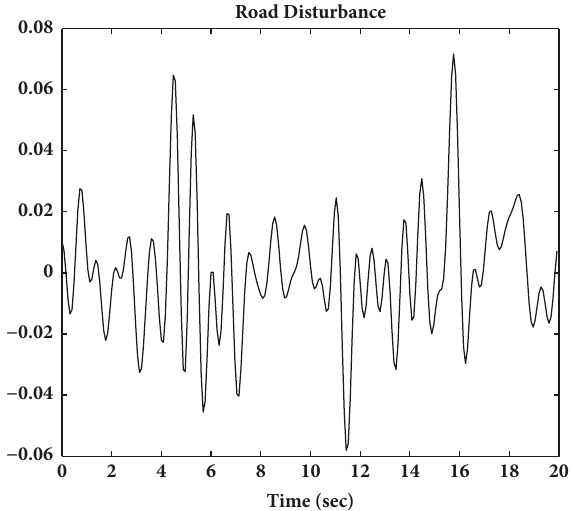
Figure 3: The curve of the road disturbance V (𝑡)